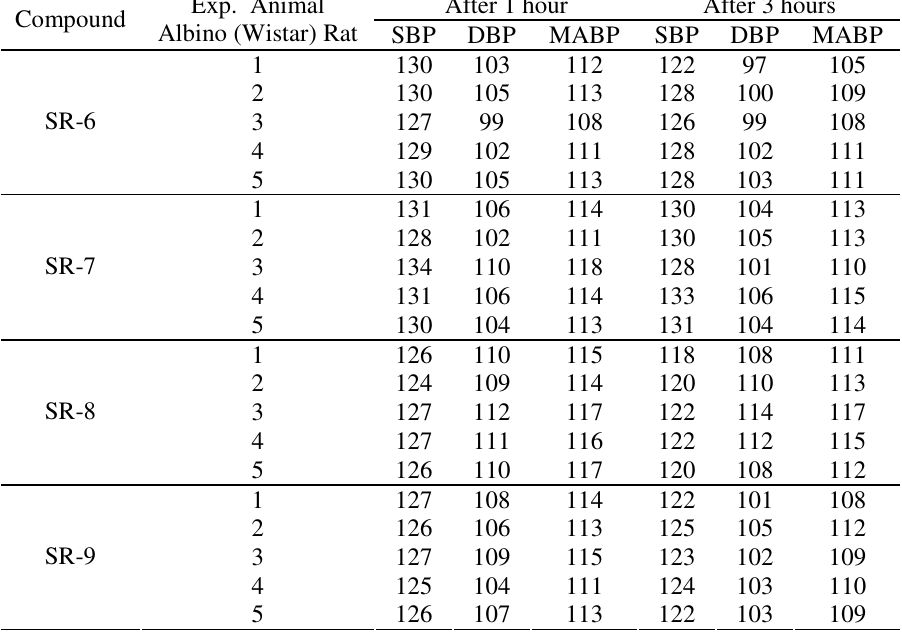
Table 2 . Reduction in blood pressure (mm Hg) at a dose of 50 µ gm/kg animal body weight. After 1 hour After 3 hours Exp. Compound